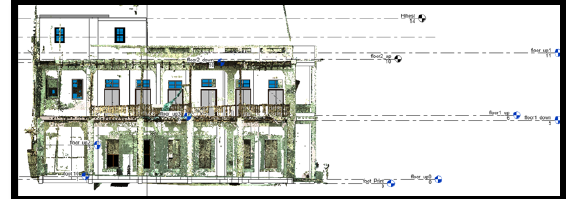
Figure 13: Creating the BIM model in Autodesk Revit.